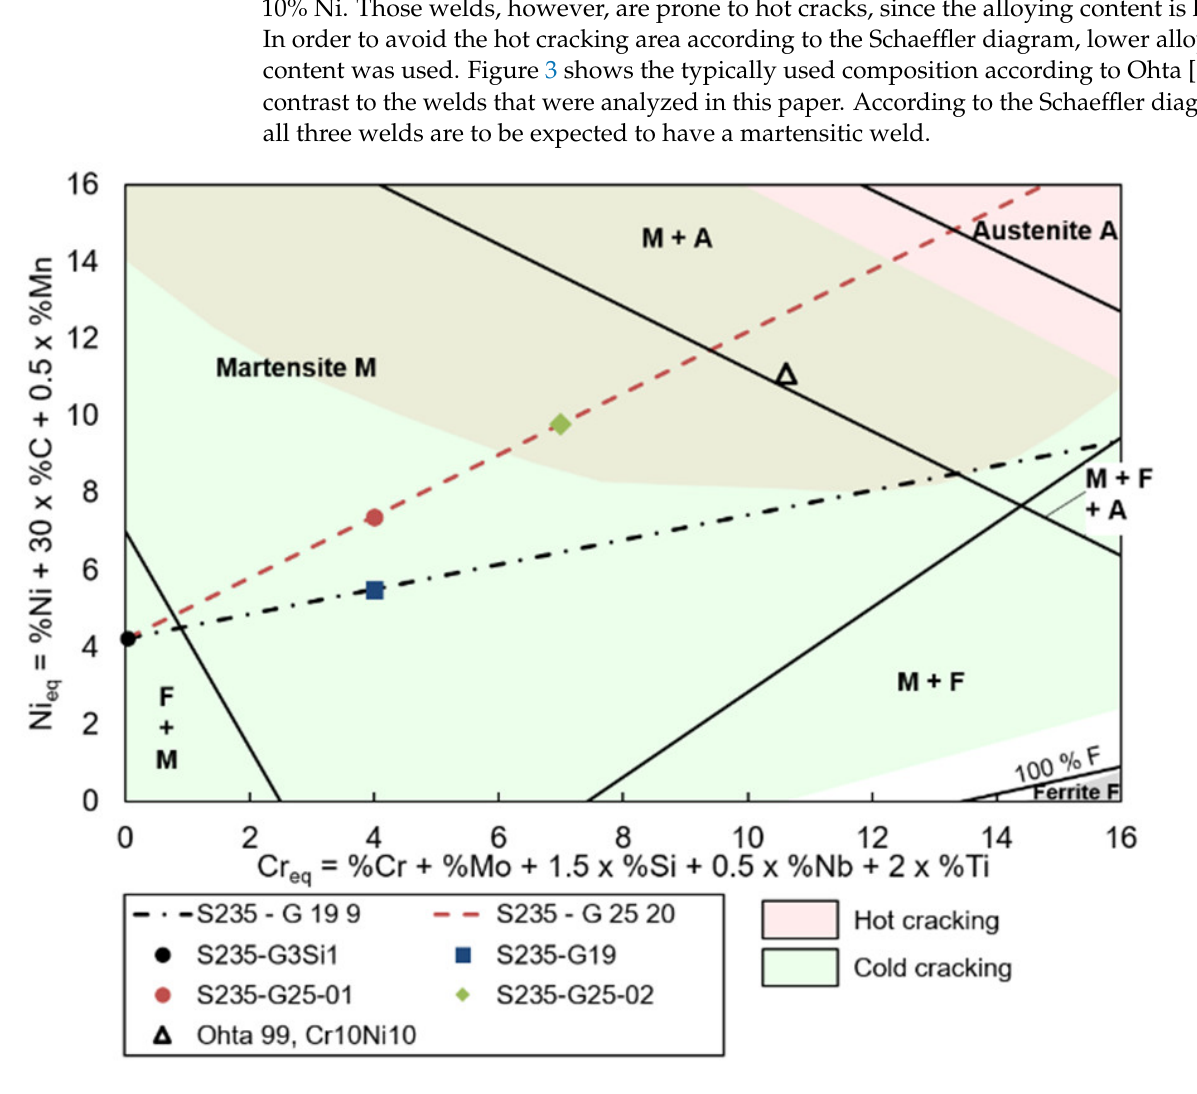
Figure 3. Placement of the welding tests in the Schaeffler diagram according to their Cr- and Ni- equivalents.